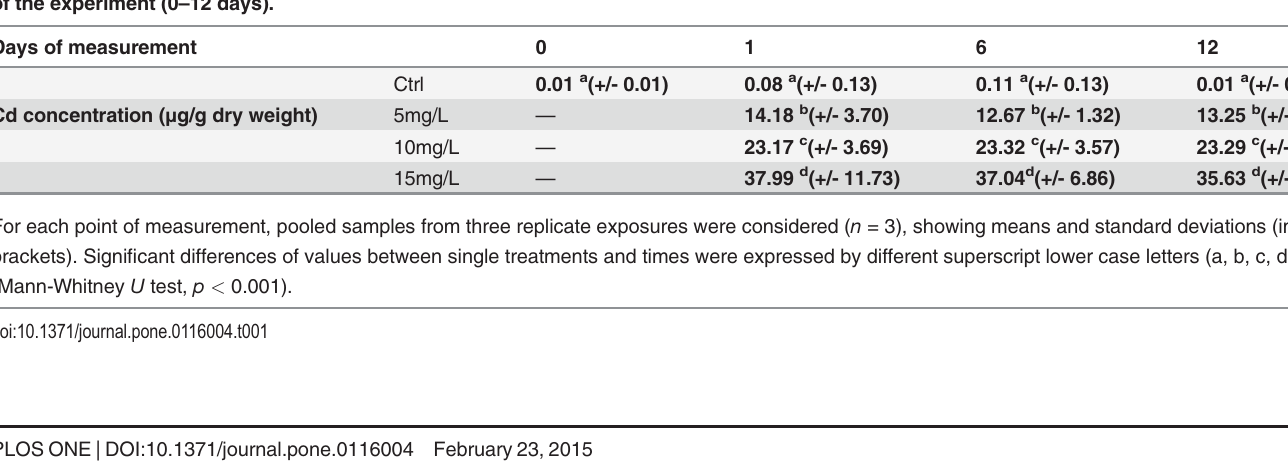
Table 1. Cadmium concentrations (mean and standard deviations in brackets) in eggs of Cantareus aspersus recorded throughout the duration of the experiment (0 – 12 days). Days of measurement Cd concentration ( μ g/g dry weight)